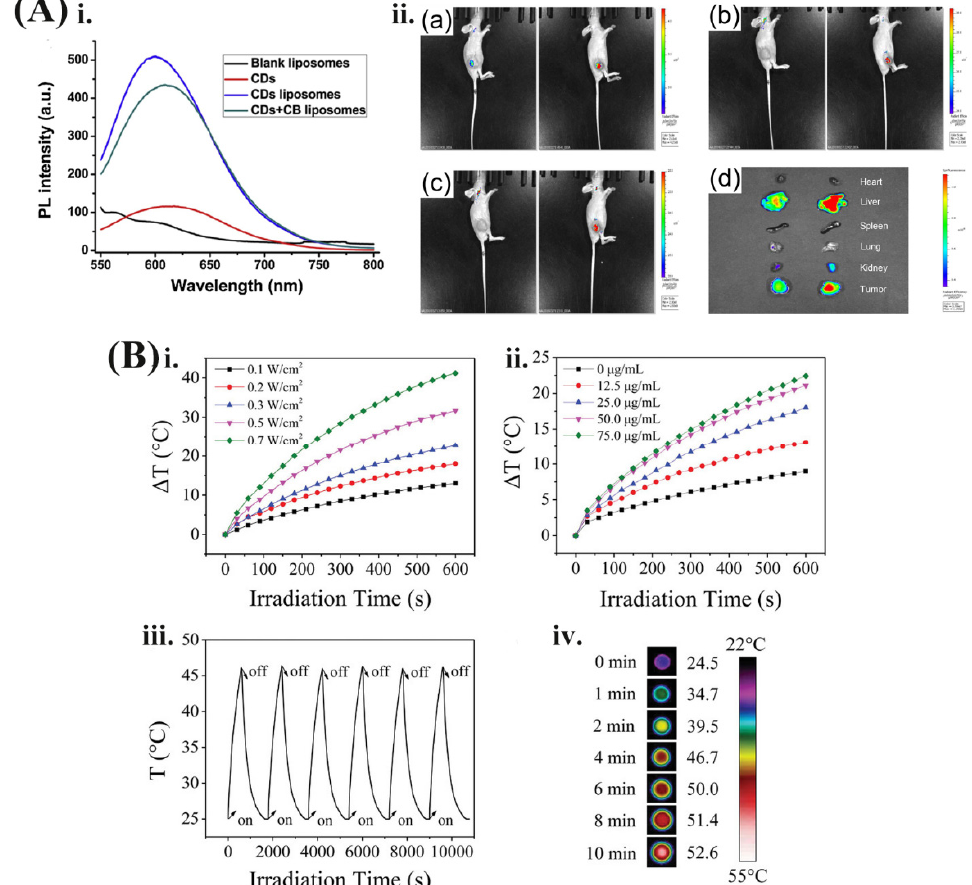
Figure 2. ( A ). ( i ) Photoluminescence intensity (PL) spectra of CDs, blank liposomes, CDs liposomes, and CDs + CB liposomes at excitation of 500 nm. ( ii ) ( a – c ) In vivo PL images of nude mice treated with intratumor injection of CDs (the left) and CDs + CB liposomes (the right) 0.25 h, 1 h, and 2 h post injection, respectively; ( d ) ex vivo images of mice tissues 24 h post tail intravenous injection of CDs (the left) and CDs + CB liposomes (the right). The color bars represent the PL intensity. Reprinted with permission from [58], Elsevier, 2018. ( B ) Measurement of photothermal property and photostability of rGO@AuNS-Lipid. ( i ) Temperature changes ( ∆ T) of the solution containing 60 µg/mL rGO@AuNS-Lipid irradiated at various laser power densities. ( ii ) Temperature change of the solution containing different concentrations of rGO@AuNS-Lipid irradiated at a laser power density of 0.3 W/cm 2 . ( iii ) Thermal stability of rGO@AuNS-Lipid (continuous six cycles of laser on/off) under 808 nm laser of 0.3 W/cm 2 . ( iv ) Infrared thermographic images recorded with a thermal infrared camera of rGO@AuNS-Lipid in 96-well plate irradiated by 808 nm laser at a power intensity of 0.1 W/cm 2 . Reprinted with permission from [37], John Wiley and Sons, 2020.